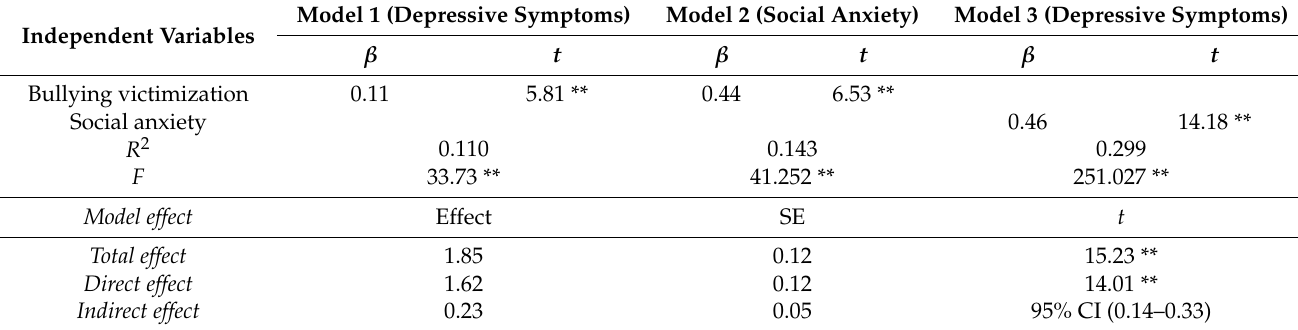
Table 3. Mediation analysis of bullying victimization’s effect on depressive symptoms.